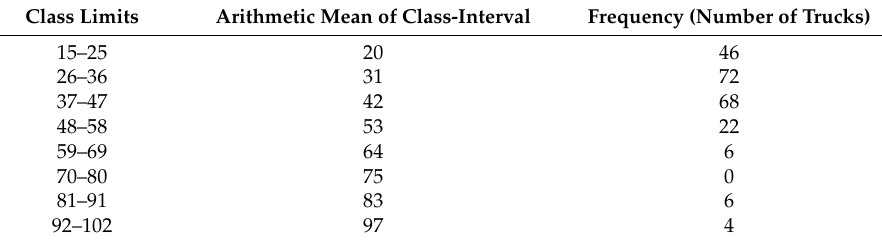
Table 3. Frequencies of the service time.